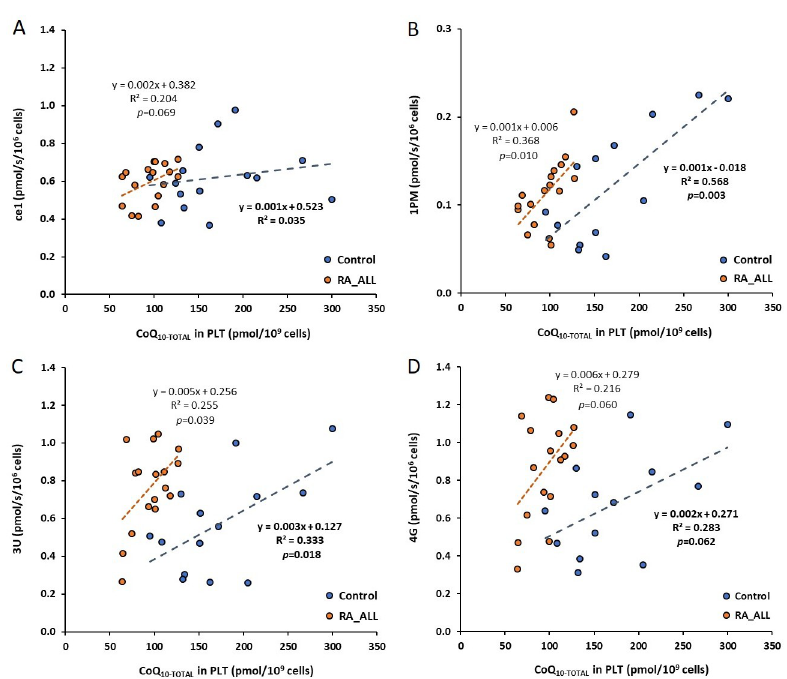
Fig 4. 4A. Correlation between CoQ 10-TOTAL in Platelets and Respiration of Intact Platelets in Control Subjects and RA_ALL Patients. ce1 = the rate of oxygen consumption in intact platelet; RA_ALL = all patients with RA; p = 0 . 069; CoQ 10-TOTAL = ubiquinol + ubiquinone; PLT = platelet . 4B: Correlation between CoQ 10-TOTAL in Platelets and Mitochondrial Respiration in Permeabilized Platelets in Control Subjects and RA_ALL Patients. 1PM = the rate of oxygen consumption in mitochondrial of permeabilized platelets (State 4); RA_ALL = all patients with RA; p = 0 . 010 , p = 0 . 003 = statistically significant; CoQ 10-TOTAL = ubiquinol + ubiquinone; PLT = platelet . 4C: Correlation between CoQ 10-TOTAL in Platelets and 3U Platelets Mitochondrial Respiration in Control Subjects and RA_ALL Patients. 3U = the rate of oxygen consumption in platelet mitochondrial noncoupled respiration at CI; RA_ALL = all patients with RA; p = 0 . 039 , in control group : p = 0 . 018; CoQ 10-TOTAL = ubiquinol + ubiquinone; PLT = platelet . 4D: Correlation between CoQ 10-TOTAL in Platelets and 4G Platelets Mitochondrial Respiration in Control Subjects and RA_ALL Patients. 4G = the rate of oxygen consumption in platelets mitochondrial noncoupled CI after addition of substrate glutamate CI; RA_ALL = all patients with rheumatoid arthritis; p = 0 . 060; CoQ 10-TOTAL = ubiquinol + ubiquinone; PLT = platelet .